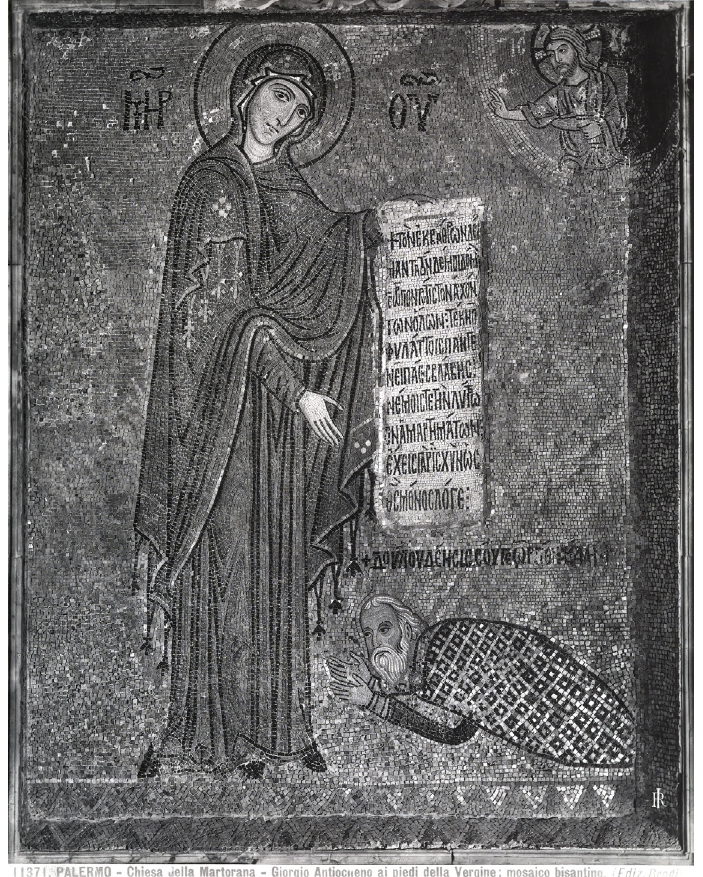
Figure 6: Palermo, St. Mary of the Admiral, Dedication panel, 12 th century mosaic wall: George of Antioch prostrate at the foot of the Virgin , Brogi, 1900 ca. (© Archivi Alinari, Firenze,